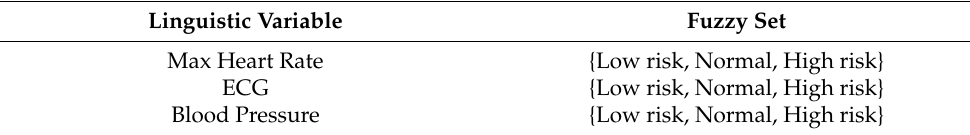
Table 2. FIS—linguistic variable and fuzzy set.